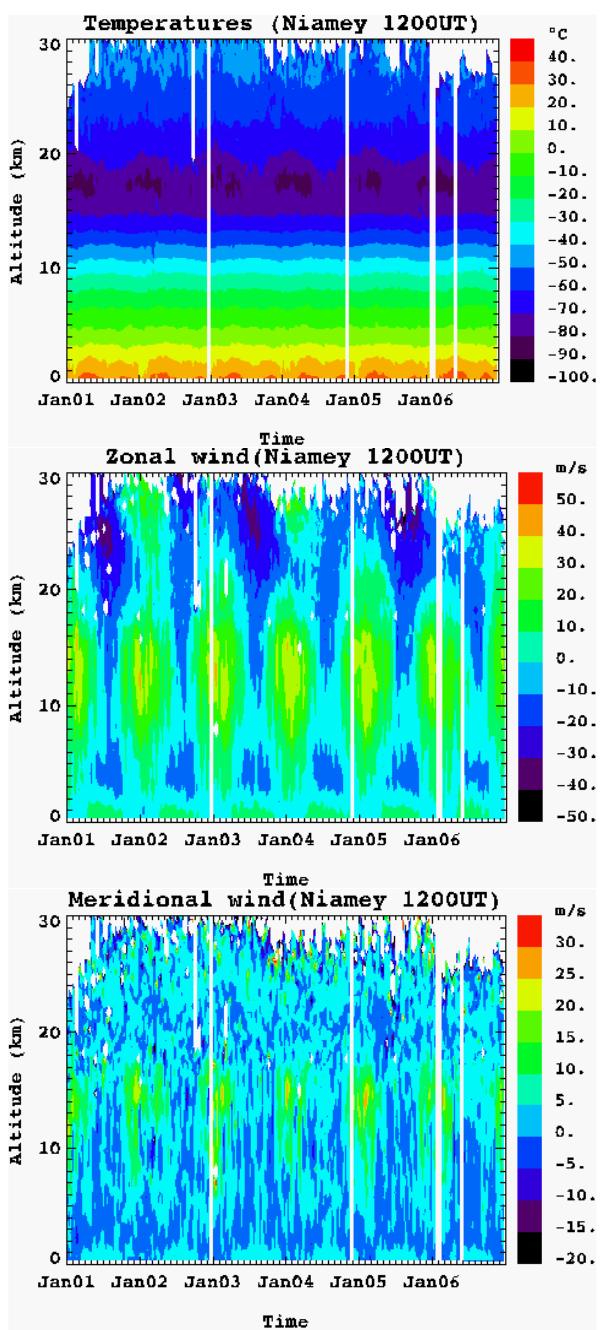
Fig. 1. Time-height cross section of 10-day mean (a) temperatures, (b) zonal and (c) meridional wind for Niamey 12:00UT radiosound-